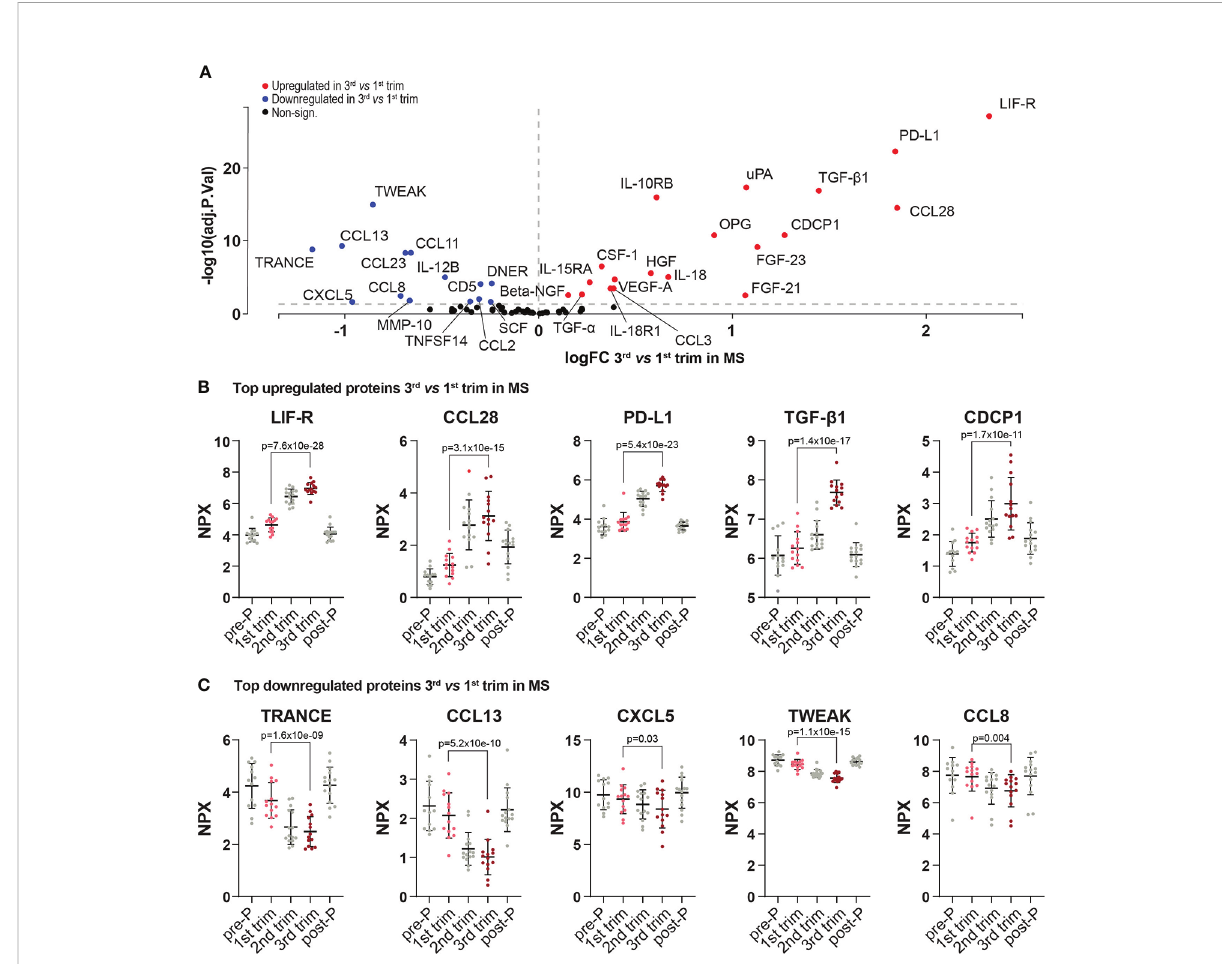
FIGURE 3 Differentially expressed proteins in 3 rd trimester versus 1 st in MS. (A) Volcano plot of the differentially expressed proteins (DEPs) at 3 rd trimester versus 1 st in MS patients. DEPs were determined using linear models and Benjamini-Hochberg correction for multiple comparisons (FDR<0.05). Up-and downregulated DEPs are shown as red and blue, respectively. Non-signi fi cant proteins are shown in black. (B, C) Dot plots of the top fi ve up-and downregulated proteins in the 3 rd trimester versus 1 st (based on logFC, FDR<0.05). To visualize the entire dynamic pattern, distribution is shown at all time-points (pre-pregnancy, during the three trimesters of pregnancy and post-partum), but only 1 st and 3 rd trimesters are shown in color and with the respective adjusted p-value. Protein levels are presented as NPX values on a log2 scale. All included proteins were also differentially expressed between post-partum and 3 rd trimester. Mean ± standard deviation is shown. logFC, logFoldChange; MS, multiple sclerosis; NPX, normalized protein eXpression; pre-P, pre-pregnancy; post-P, post-partum; trim,